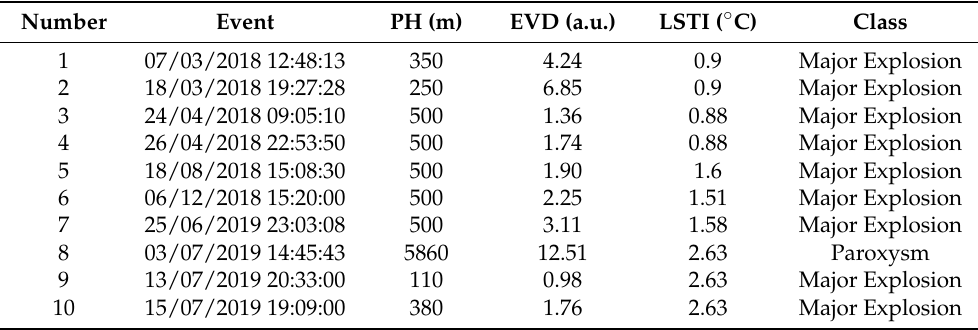
Figure 3. Time series of LFTS (a), LSTI (b), and EVD (c) values calculated from January 2018 to April 2021. (a) and (b) The red stars indicate the explosive events listed in Table 1. (c) EVD is computed for each Sentinel-1 acquisition (blue dots). EVD values corresponding to the investigated eruptive events are shown as red dots. Table 3. List of the input features and classification outcome between “paroxysm” and “major explosion” for each eruptive event at Stromboli volcano. Date and time in dd/mm/yyyy hh:mm:ss format. Time is expressed in